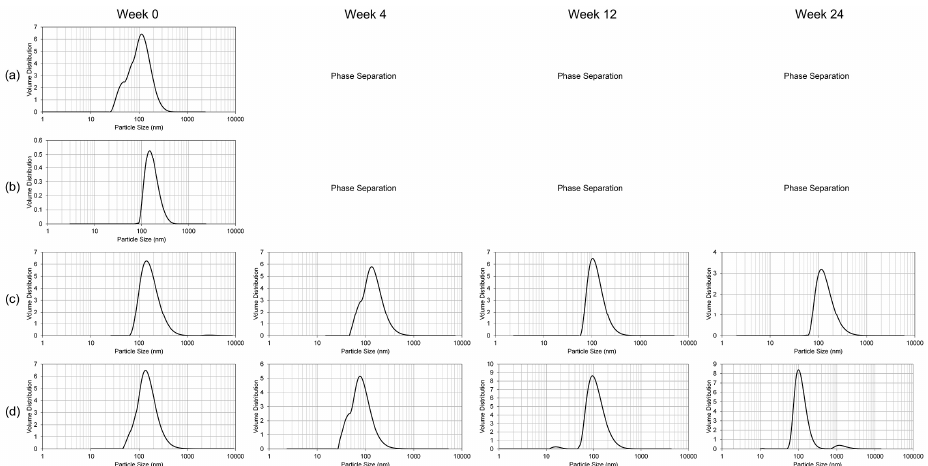
Figure 4. Particle size distribution over time for ( a ) liquid blank NE; ( b ) liquid GT3 NE; ( c ) lyophilized blank NE; and ( d ) lyophilized GT3 NE stored at − 20 °C.